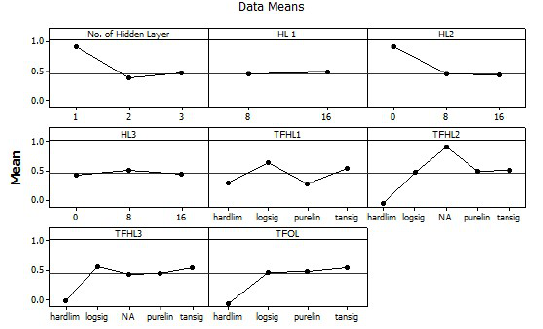
Fig. 12. Main Effects Plot for Validation Perfor- mance